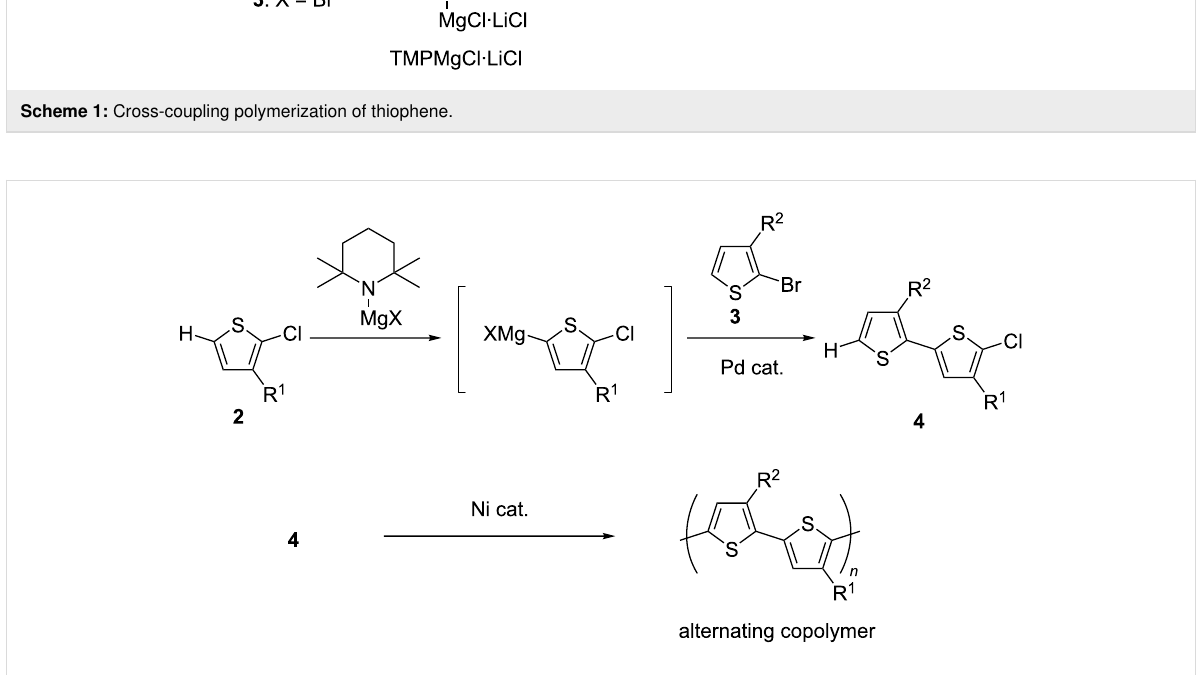
Scheme 2: Polymerization of